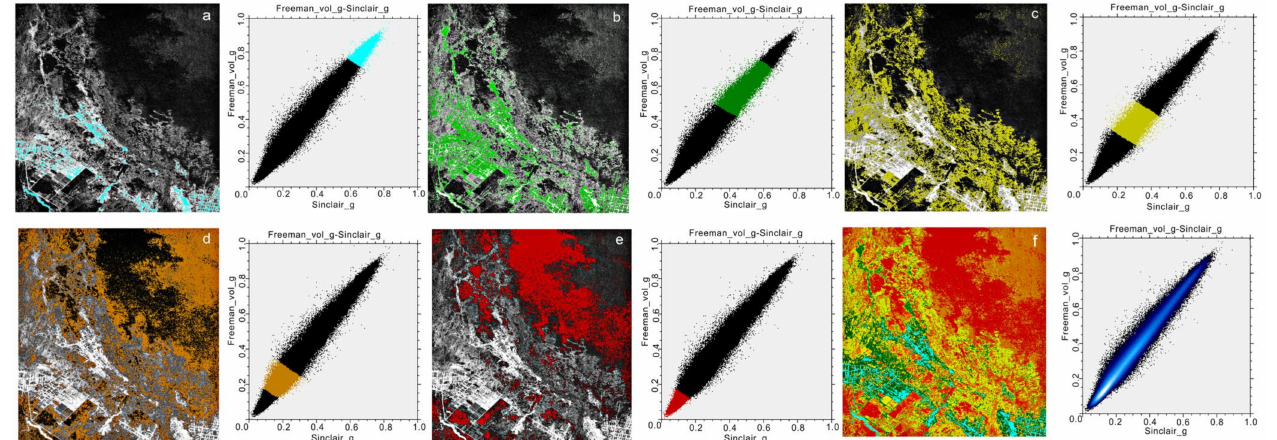
Figure 7. Illustration of different feature types and soil salinization contents in images in the SF feature space: ( a ) water bodies; ( b ) plant cover; ( c ) slight salinization; ( d ) moderate salinization; ( e ) severe salinization; ( f ) spatial distribution patterns of different levels of soil salinization.